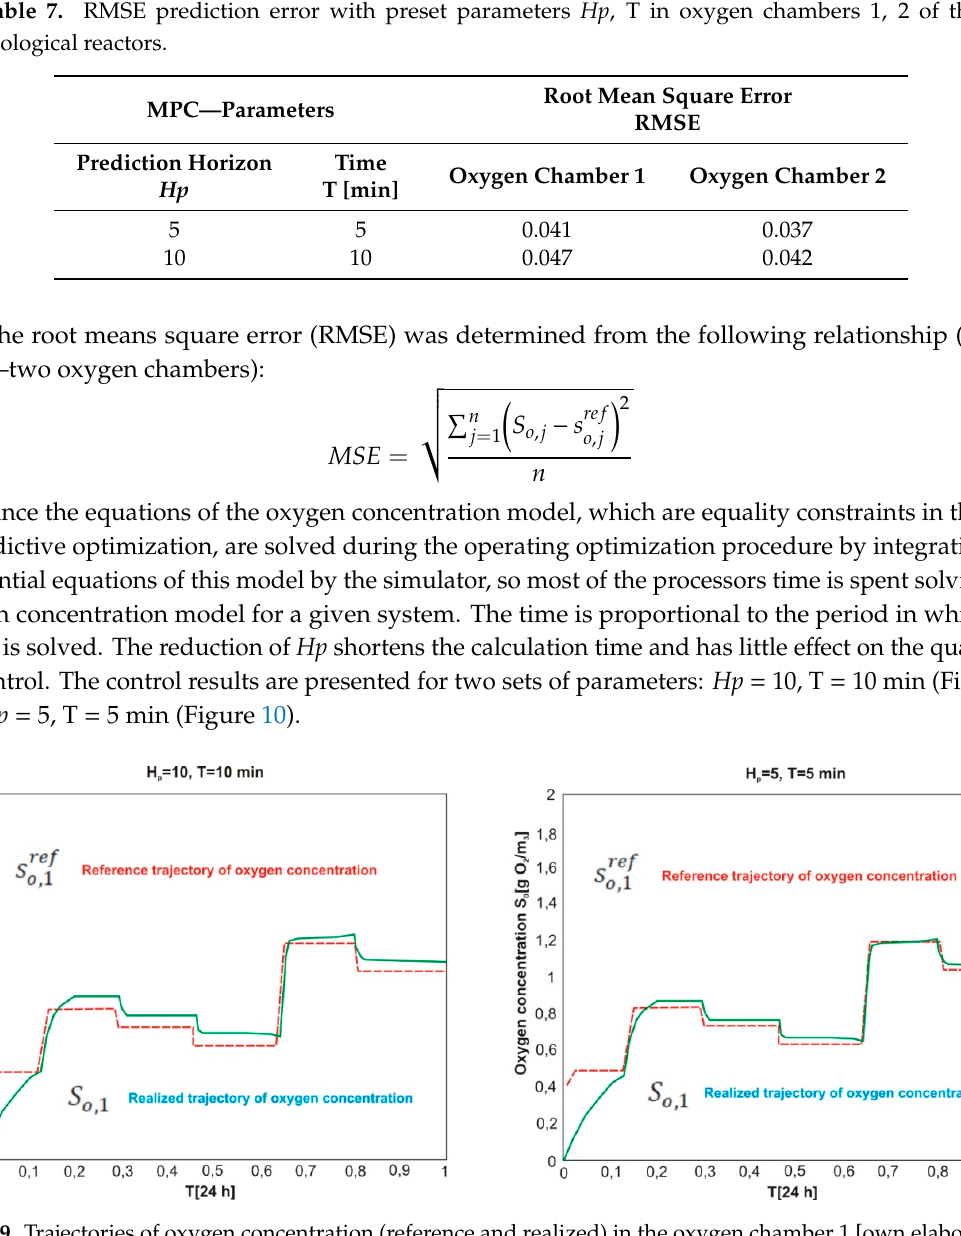
Figure 9. Trajectories of oxygen concentration (reference and realized) in the oxygen chamber 1 [own elaboration].